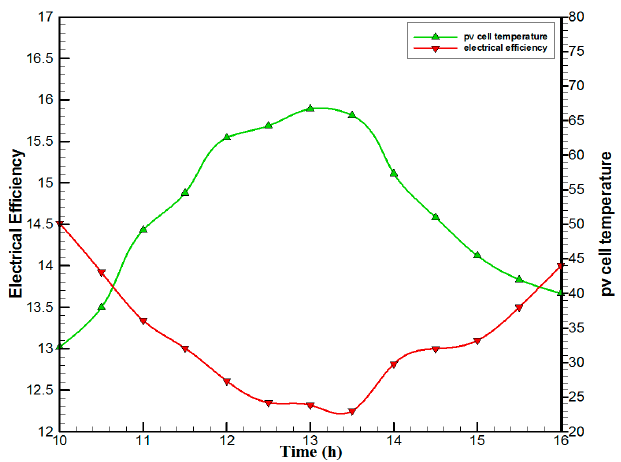
Figure 6. The hourly variation of electrical efficiency and solar cell temperature for the PVT solar collector with CPC.